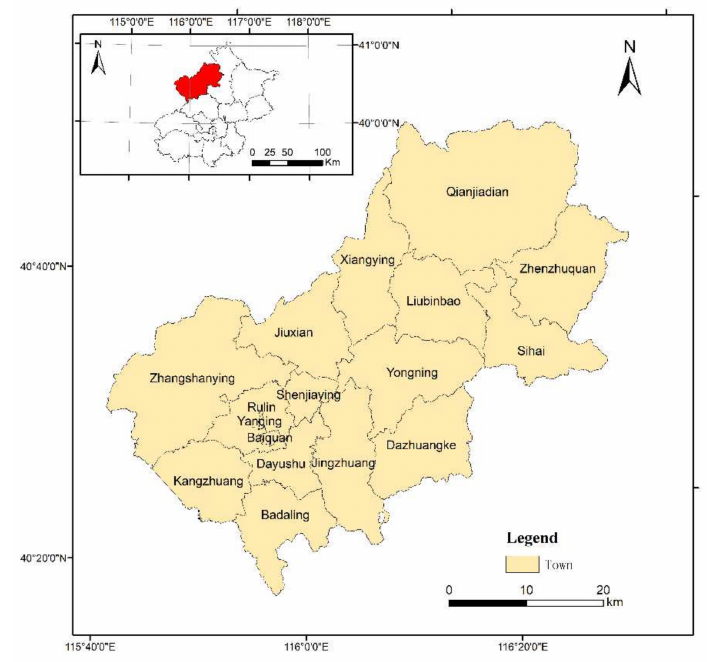
Figure 4. Case study area. The red plate is the location of Yanqing in